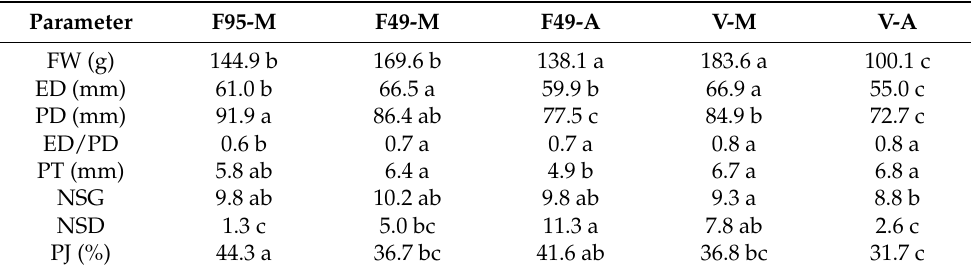
Table 2. Morphological characterization of lemons (“Fino 95”, “Fino 49” and “Verna”) obtained in different rootstocks ( C. macrophylla and C. aurantium ), with emphasis on the weight fruit (FW), equatorial diameter of the fruit (ED), polar diameter of fruit (PD), Peel thickness (PT), Number of fruit segments (NSG), Number of seeds (NSD) and percentage of juice (PJ). The values represented are the